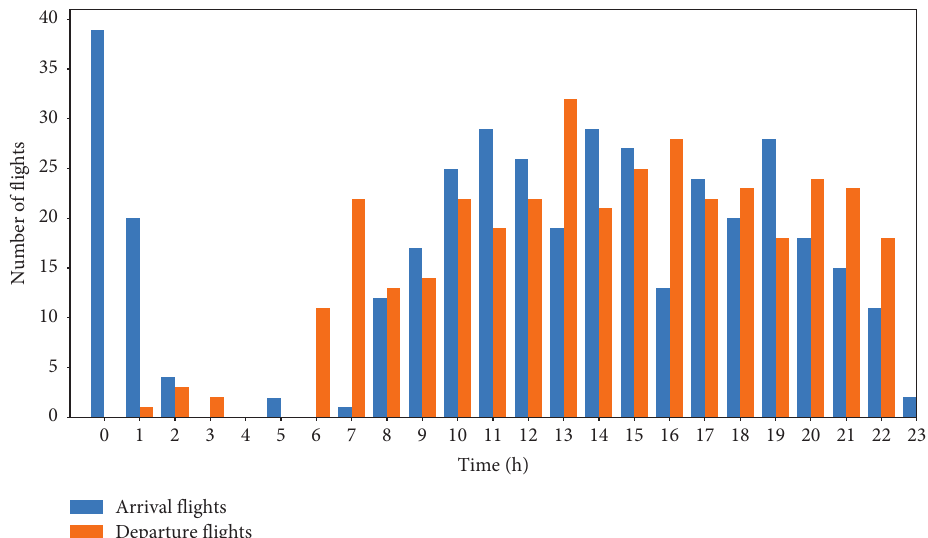
Figure 5: Schematic diagram of flight arrival and departure